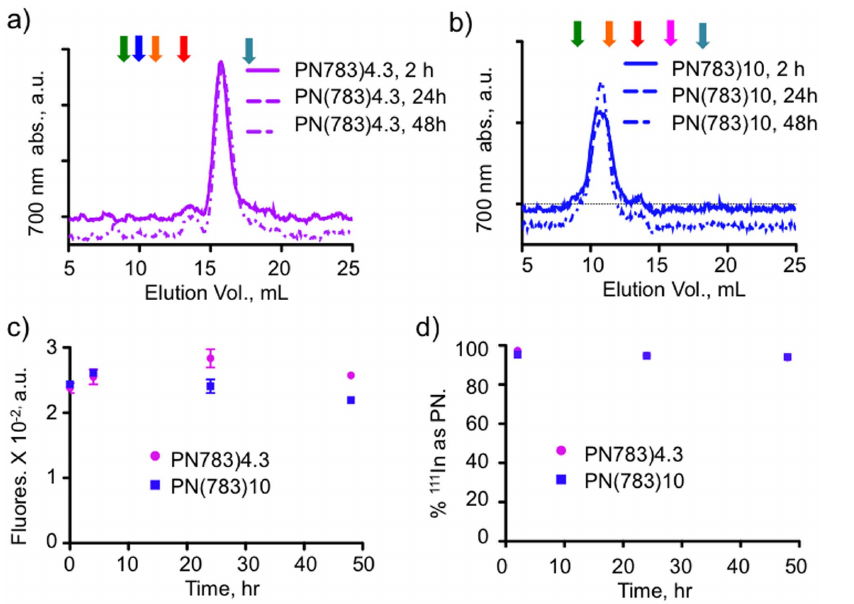
Figure 7. Stability of PN’s in mouse serum. The stability of PN(783)4.3 A ) or PN(783)10.0 B ) was examined by incubating nanoprobes for the indicated times and subjecting samples to FPLC. Arrows are the retention times of PN’s from Figure 2A , color coded as in that figure. Fluorochrome size is unchanged for both PN’s. C ) Stability of PN fluorescence. PN(783)4.3 or PN(783)10.0 were incubated as indicated and fluorescence determined. D ) Stability of 111 In binding to PN’s. 111 In-PN(783)4.3 or 111 In-PN(783)10.0 were incubated as indicated and radioactivity associated with the PN determined by HPLC. Exemplary chromatograms are provided; see Figure S6 in File S1.